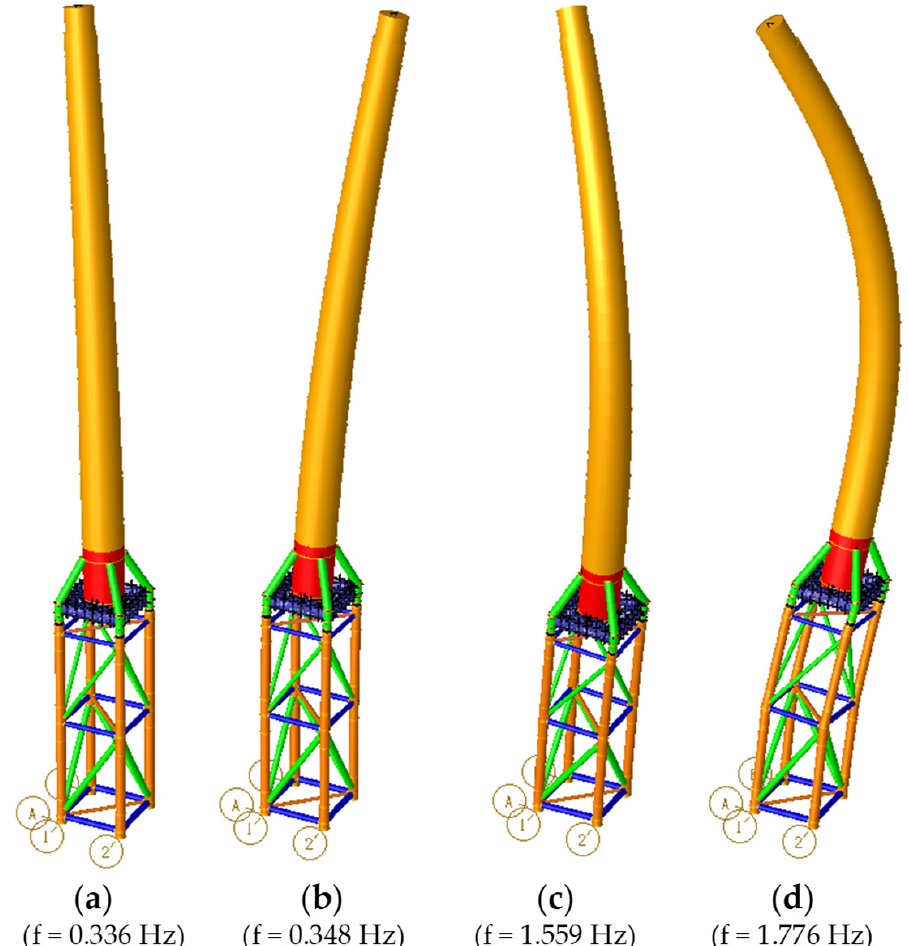
Figure 4. Mode shapes of the support structure: ( a ) Mode 1; ( b ) Mode 2; ( c ) Mode 3; ( d ) Mode 4. For higher mode shapes, eigenvalues of 1.559 Hz for the third mode and 1.776 Hz for the fourth mode, which lay beyond the upper boundary of the 3-blade passing frequency range (i.e., 0.35–0.6 Hz), are